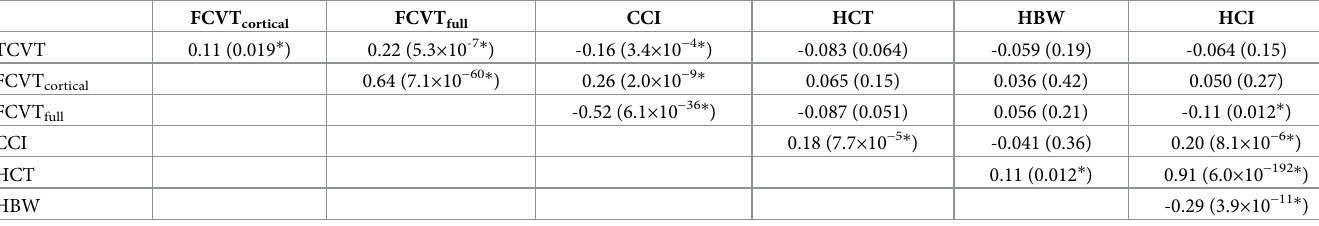
Because of sexual dimorphism in body size, males usually have a larger postcranial bone vol- ume than females [28]. Some previous studies have shown that even after controlling for body Table 4. Partial correlation coefficients between